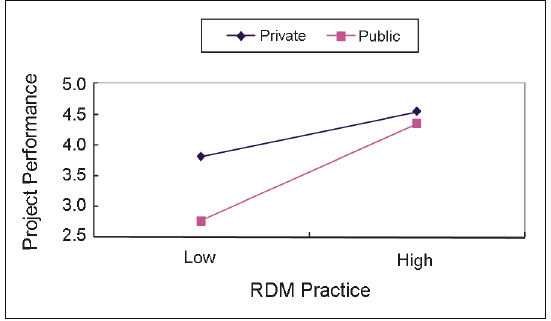
Fig. 2. Moderating role of owner